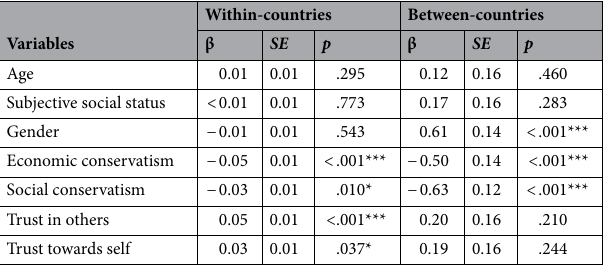
Table 1. Replication results for variables recorded at the individual level. Gender was coded as male (1) and female (2). * p < .05, ** p < .01, *** p < .001.